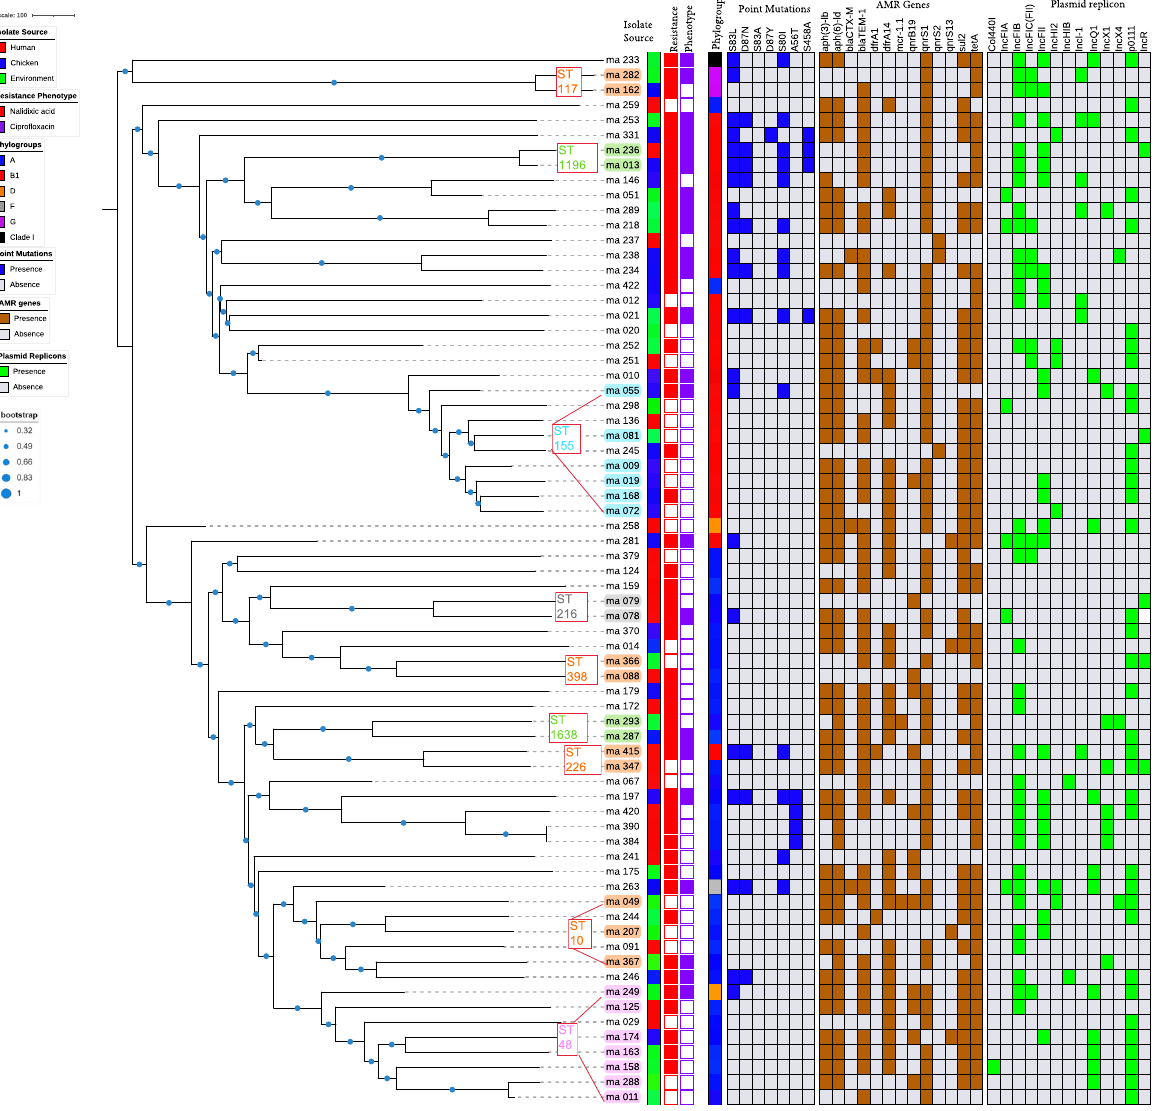
Fig. 4 Core genome MLST-based phylogeny of PMQR Escherichia coli isolates ( n 70) from humans, chickens, and poultry environments. = cgMLST-based phylogenetic tree of PMQR E. coli isolates visualized in Interactive Tree Of Life tool (iTOL). The clustering of isolates was found to be following the core genome. The clustering of isolates belonging to the same phylogroup and sequence type was consistent. Shown for each isolate from left to right are the source, resistance phenotype, phylogroup, point mutations, AMR genes, and plasmid